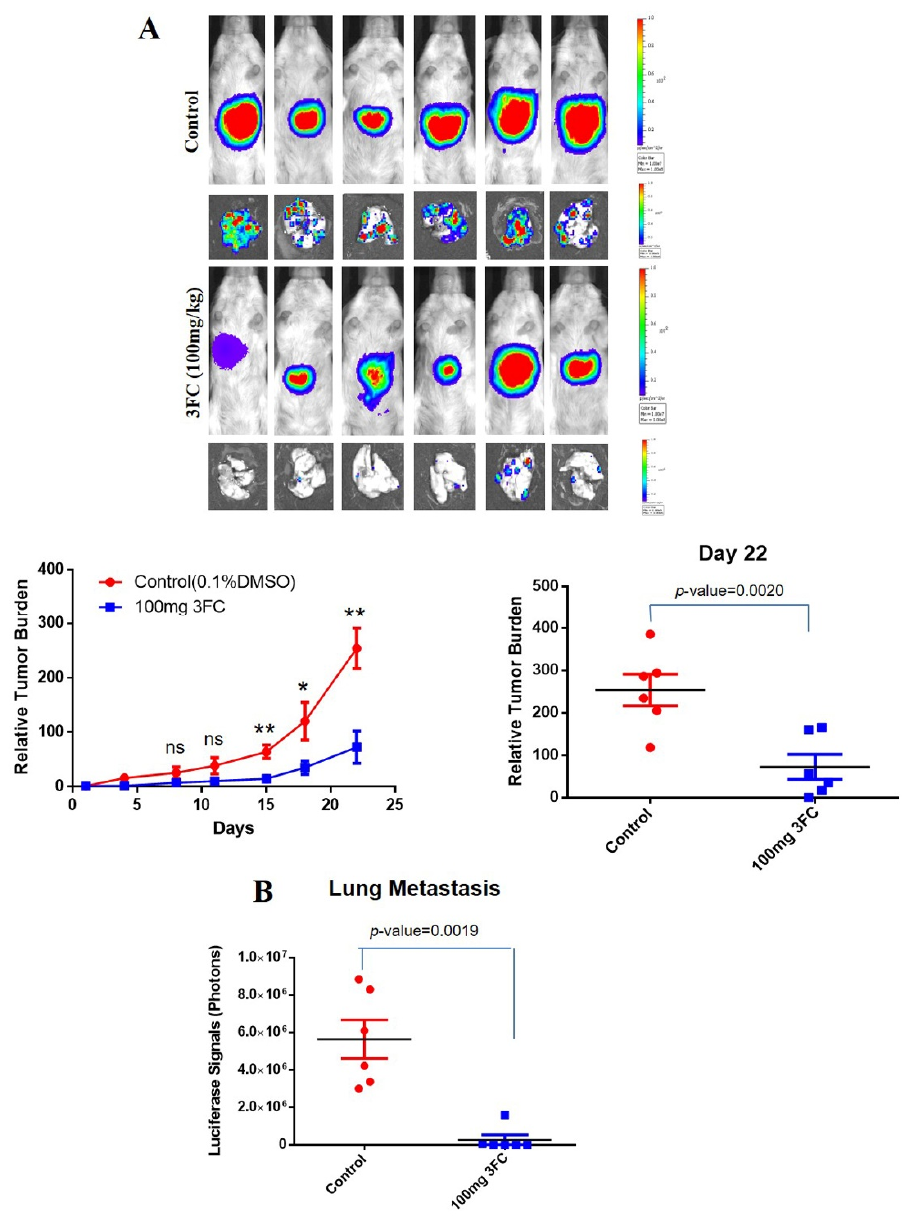
Figure 4. ( A ) Growth-inhibitory effect of 3FC on HCCLM3-Luc cells implanted in mice. ( B ) Lung metastasis was measured by quantifying the bioluminescence signals from the secondary tumor site. * p < 0.05, ** p < 0.01. The tumors generated using HCCLM3-Luc cells were orthotopically implanted into 8-week-old male SCID mice ( n = 6), and tumor progression was analyzed. When the tumor reached 10 6 , animals were intraperitoneally administered with 3FC (100 mg/kg body weight, three doses per week) for four weeks, and the growth of the tumor was examined by measuring the photon count.